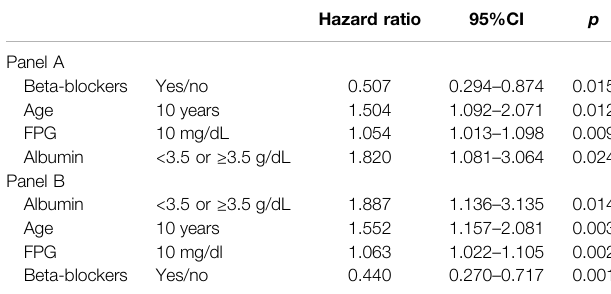
TABLE4| Univariable(panelA)andmultivariable(panelB)Coxregressionanalysis for cardiovascular event occurrence (albumin as dichotomous variable). Hazard